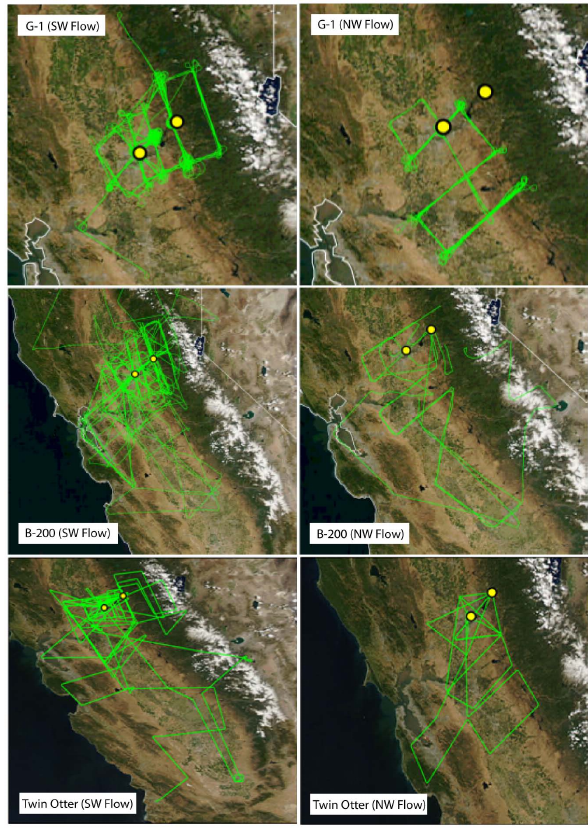
Fig. 4. DOE G-1, NASA B-200, and NOAA Twin Otter Flight Tracks during the SW and NW flow periods. The yellow circles indicate the locations of the T0 and T1 ground sites.